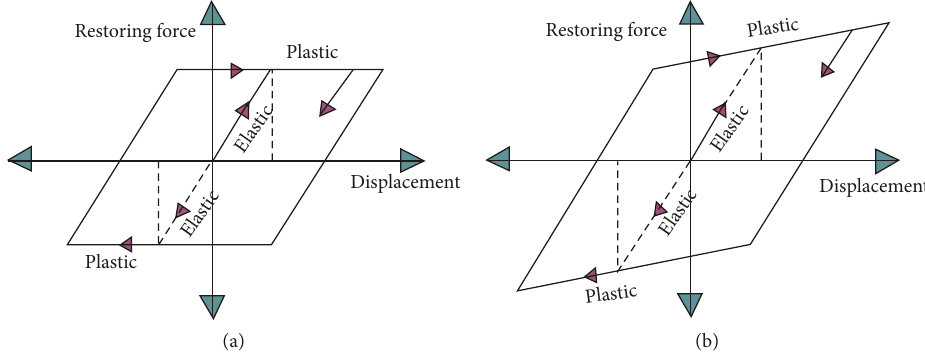
Figure 4: Elastoplastic material models: (a) elastic-perfect plastic model and (b) elastic-plastic with kinematic